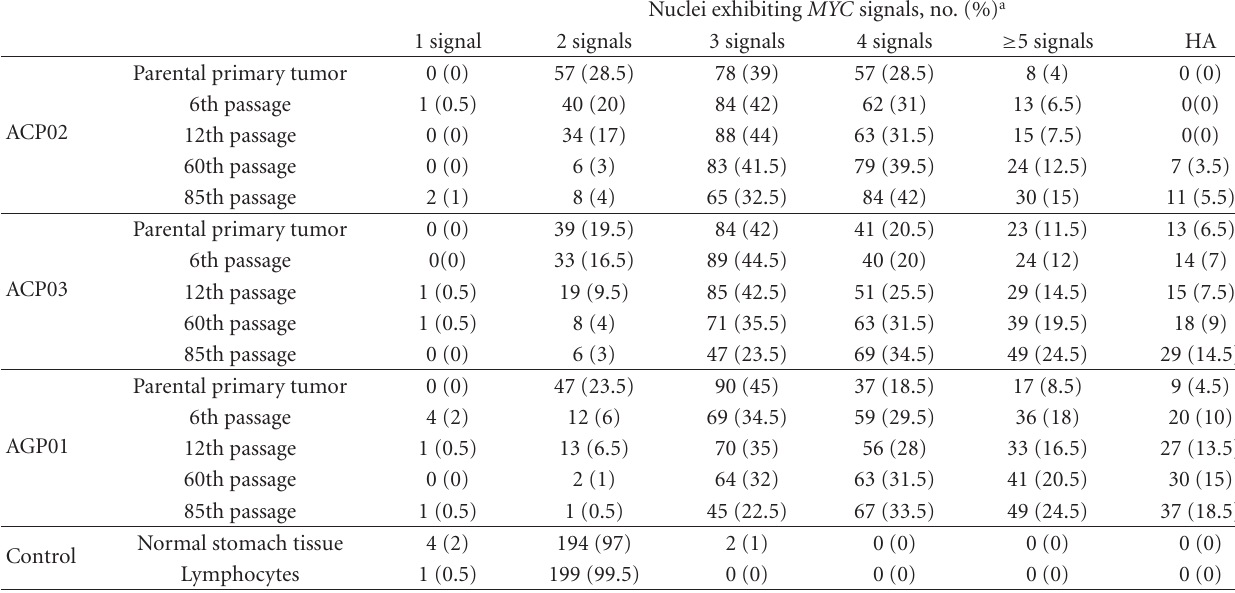
Table 1: FISH analysis of MYC copy number in gastric cancer cell lines, in their parental primary tumors and in control samples. Nuclei exhibiting MYC signals, no. (%) a